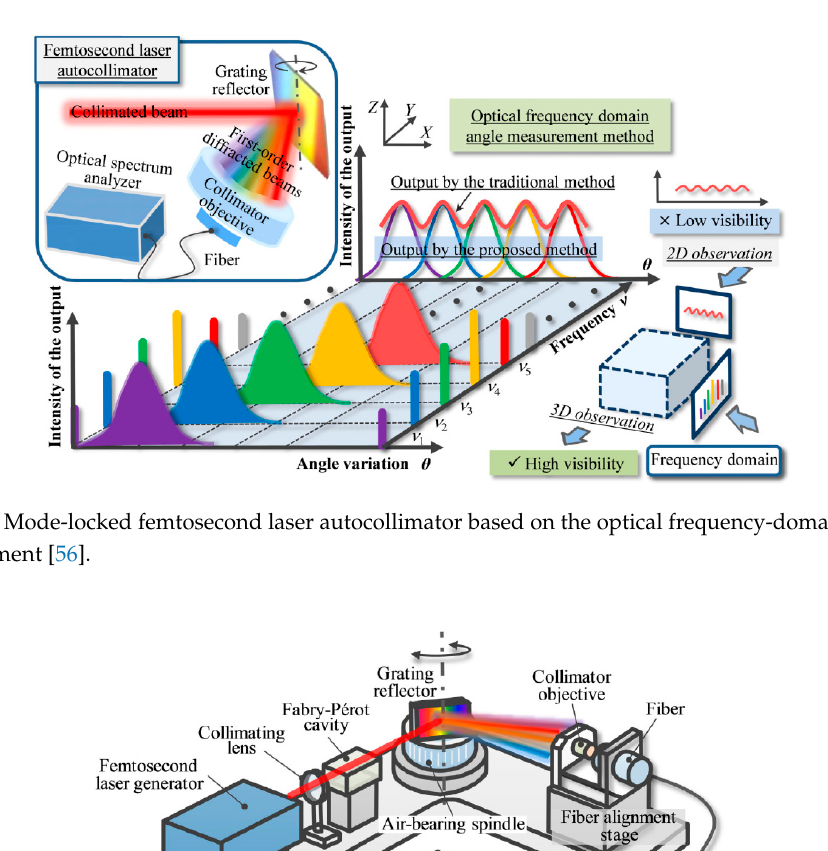
Figure 6. Mode-locked femtosecond laser autocollimator based on the optical frequency-domain angle measurement [56].